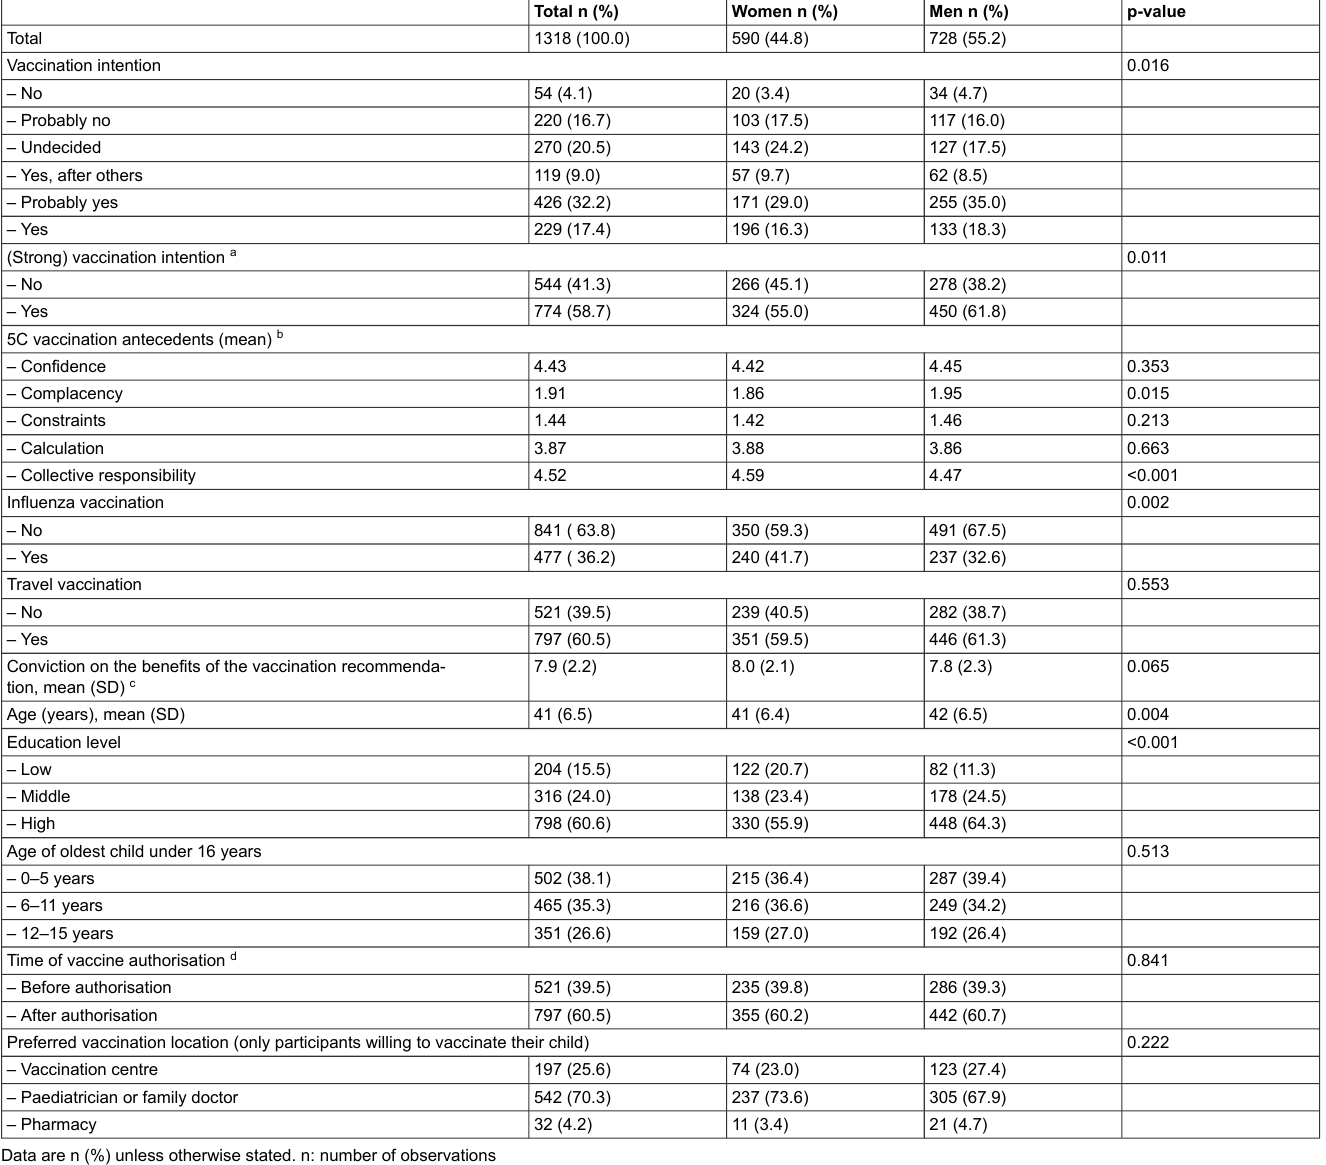
Table 1: Characteristics of the study population (n =